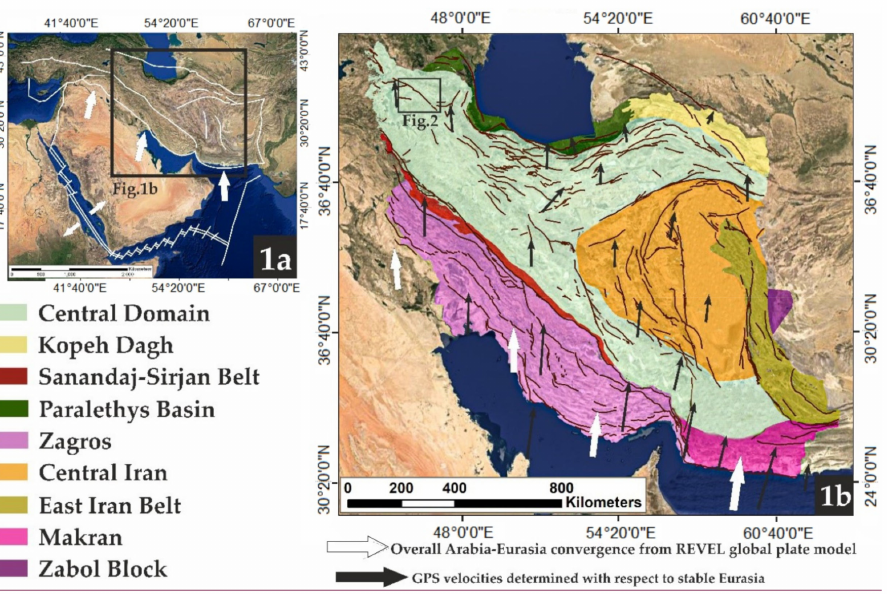
Figure 1. The tectonics of Iran. ( a ) is inset map showing Iranian plateu; ( b ) seismotectonic regions of